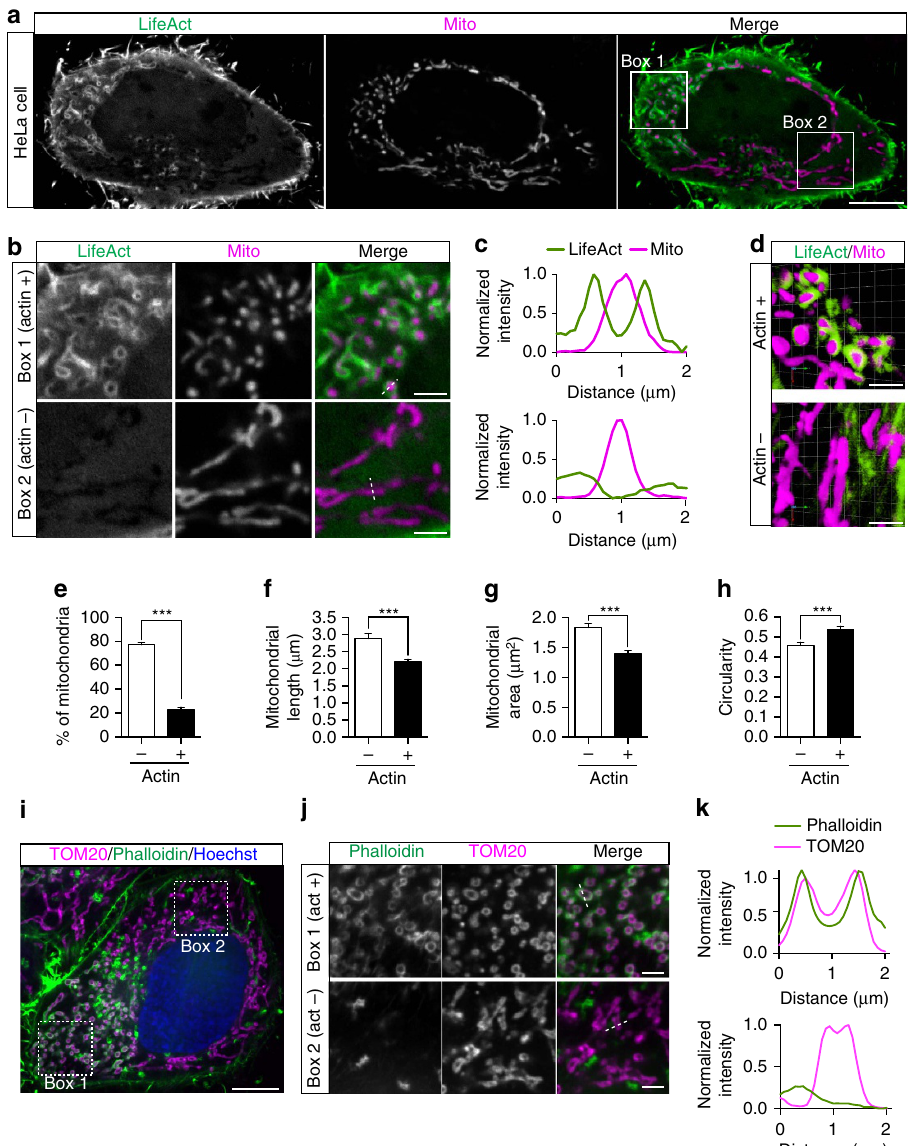
Figure 1 | F-actin localizes to subpopulations of mitochondria. ( a ) Confocal microscopy image of F-actin (LifeAct-GFP) localization to a subset of Mito-DsRed2-labelled mitochondria in HeLa cells. ( b ) Enlarged images showing fragmented, actin-positive mitochondria (Box 1) and elongated, tubular mitochondria that have not recruited actin (Box 2). ( c ) Line scans of actin-positive mitochondria (top) and actin-negative mitochondria (bottom). ( d ) Three-dimensional renderings of z -stack images showing differential morphologies of actin-positive mitochondria (top) and actin-negative mitochondria (bottom) within the same cell. ( e ) Percentage of actin-positive and actin-negative mitochondria per cell. ( f , g ) Mitochondria that have recruited actin have decreased length and area. ( h ) Actin-positive mitochondria have a significantly higher circularity index than actin-negative mitochondria. ( i ) Confocal image of phalloidin recruitment to mitochondria labelled with anti-TOM20 antibody in a fixed HeLa cell. ( j ) Enlarged images from the boxed region in i displaying differential morphologies of phalloidin-positive and phalloidin-negative mitochondria. ( k ) Line scans of individual mitochondria from the regions shown in j showing co-localization of the TOM20 outer membrane marker with phalloidin (top) and TOM20 without actin co-localization (bottom). Values represent means ± s.e.m. *** P o 0.001. Scale bars, 10 m m ( a , i ); 2.5 m m ( b , d , j ). Sample size: ( e ) 19 cells, ( f ) 9 cells, ( g ) 10 cells, ( h ) 26 cells. N Z 3 independent experiments in all cases.